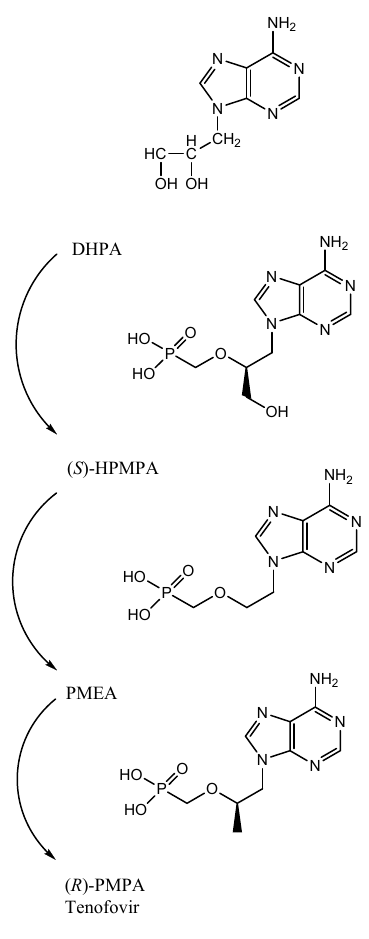
Figure 1. Genealogy of